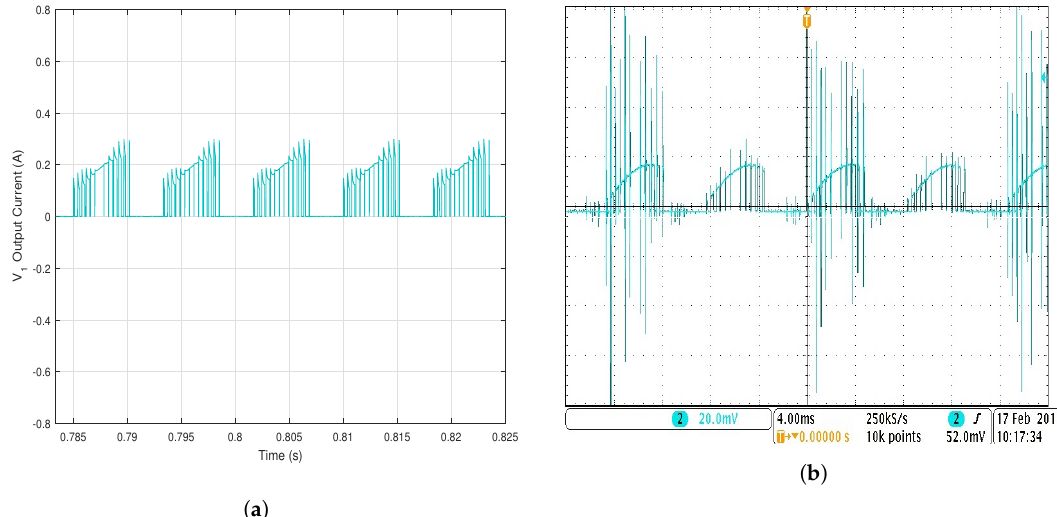
Figure 11. Results of five-level SS MLI: ( a ) simulated source, V 1 , DC current; ( b ) experimental source, V 1 DC